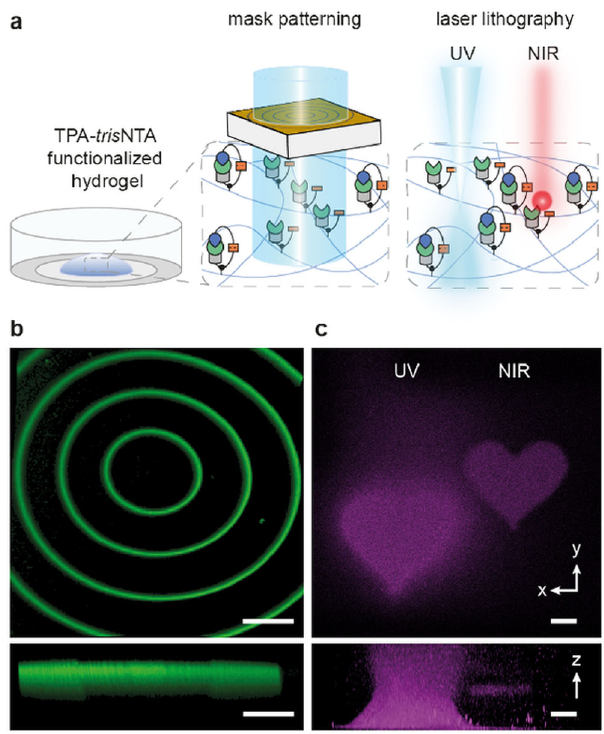
Fig. 3 In-situ protein assembly in 3D by one- and two-photon excitation. a Schematic illustration of photoactivation in hydrogels by mask patterning or laser lithography using UV or NIR light. b Mask patterning of circular structures using a 405 nm UV/LED system (185 mW/cm 2 for 60 s) showed a very good contrast between illuminated and non-illuminated areas (top). Photopatterning occurred in three dimensions with a penetration depth of 100 µ m and uniform organization of GFP-His 6 (bottom). 3D structures were visualized by immobilization of GFP-His 6 , and images were reconstructed from a series of z stacks. Scale bars: 100 µ m.